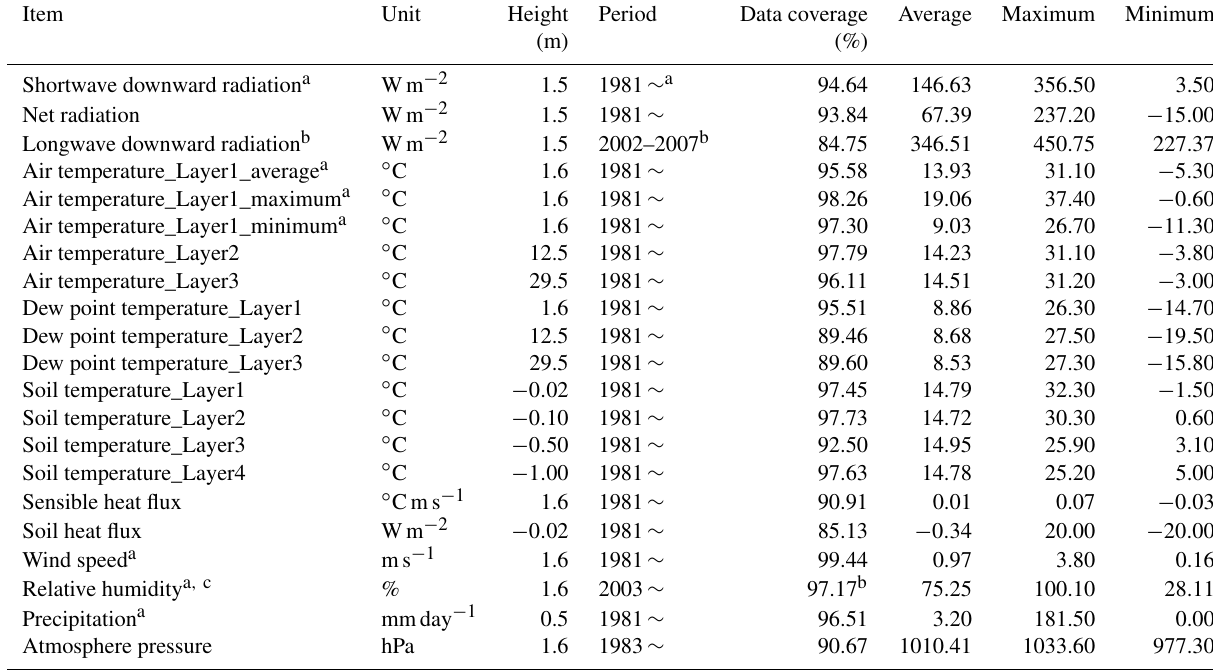
Table 2. Parameter information within the EDP database. Locations A, B and C are located within the observation site of the EDP department as shown in Fig.